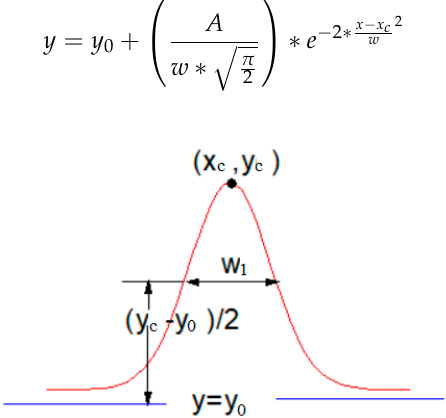
Figure 8. The sample curve corresponding to the Gaussian fit in Origin Lab.